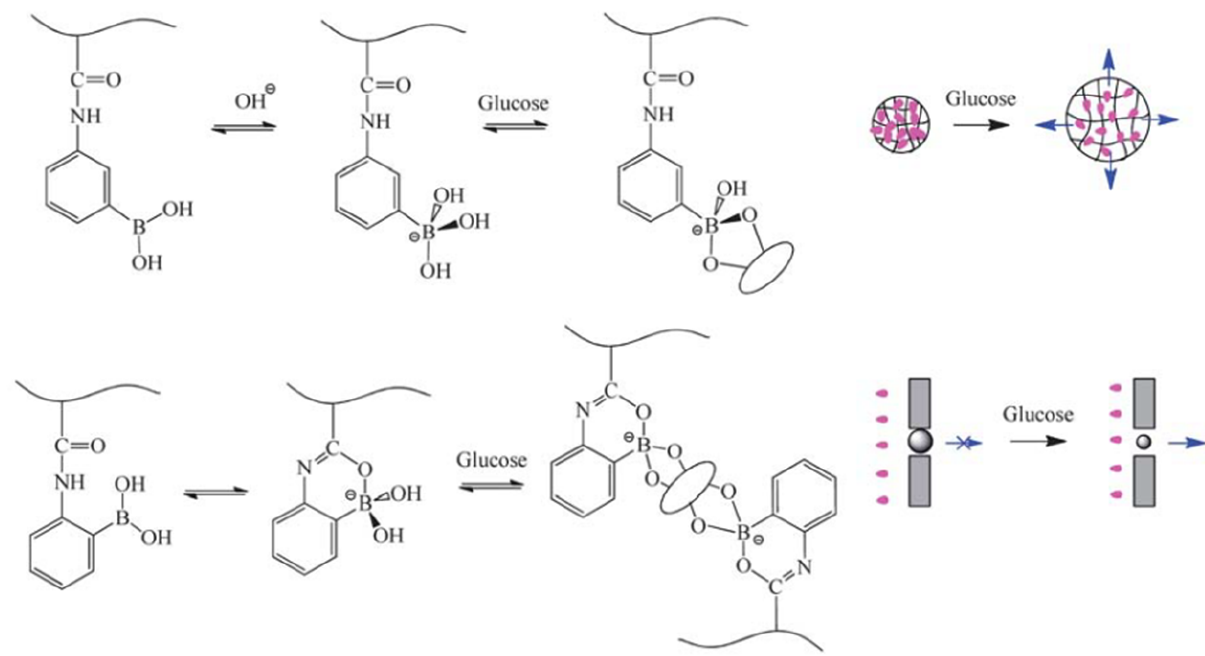
Figure 7: The complexation equilibrium between glucose and PBA groups, and the glucose-induced swelling of P(NIPAM-AAPBA) microgels. Reproduced with permission from [43]. Copyright 2014, The Royal Society of Chemistry